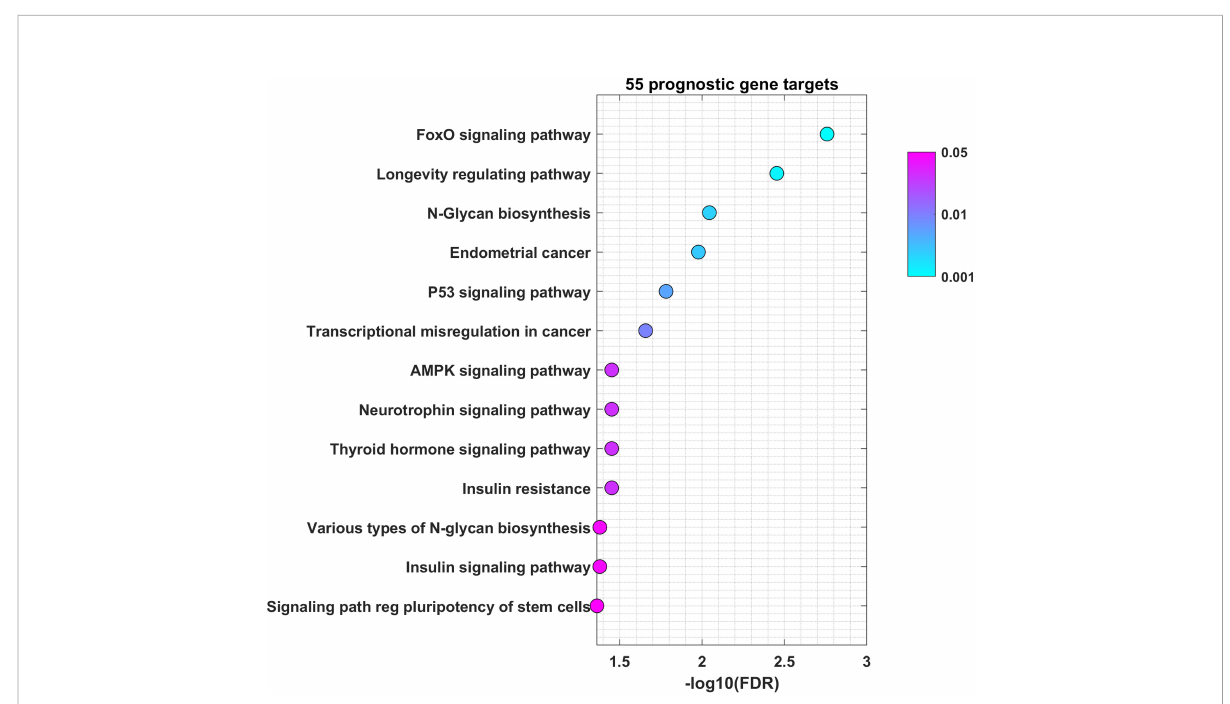
FIGURE 6 miR-21-5p, miR-93-5p, miR-146b-5p, miR-155-5p, miR-182-5p and miR-133b control genes involved in FOXO, longevity, glycan biosynthesis and p53 pathways in OSCC. Bubble plot containing speci fi c ontological groups of miR-21-5p, miR-93-5p, miR-146b-5p, miR-155-5p, miR-182- 5p and miR-133b validated targets. The graphs represents only the GO groups above the established cut-off criteria (p with correction <0.05, minimal number of genes per group >10). Each bubble displays the number of differentially expressed genes assigned to the particular GO terms. The transparency of the bubbles shows the p-values (the darker the violet color, the closer to the border of p = 0.05).